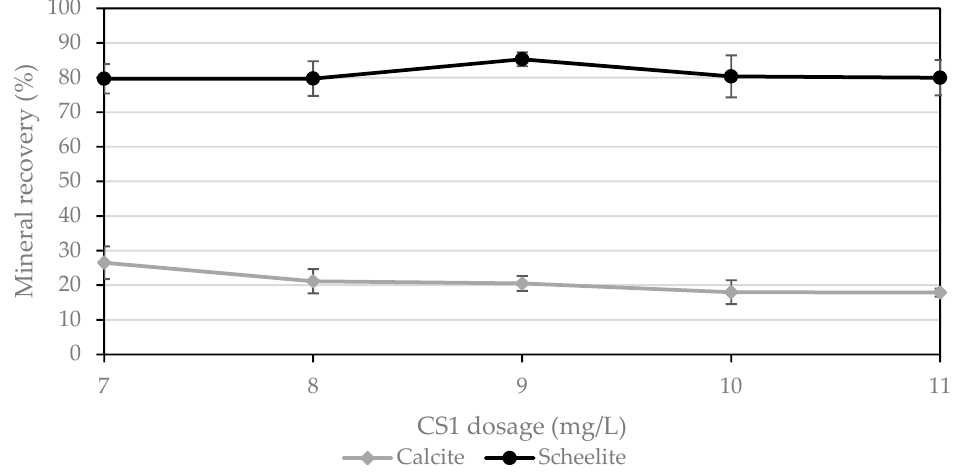
Figure 9. Single-mineral flotation recovery of calcite and scheelite depending on the pH (collector = 1 × 10 − 4 sodium oleate, depressant = 25 mg/L CS1, error bars represent the 95% confidence interval).